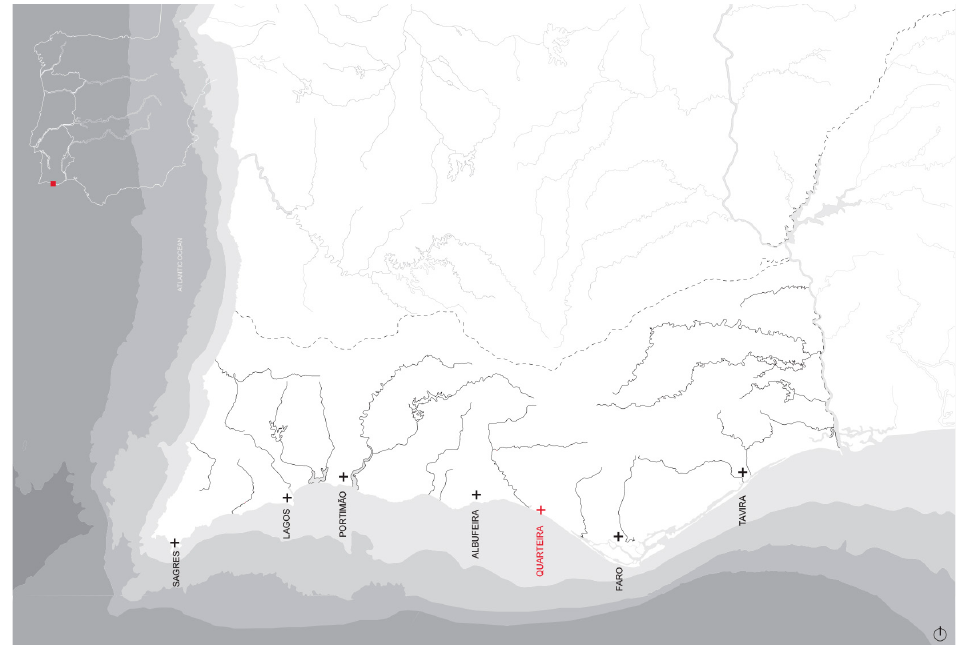
Figure 2. Quarteira location in the Algarve coast. Authors’ edition, 2023.